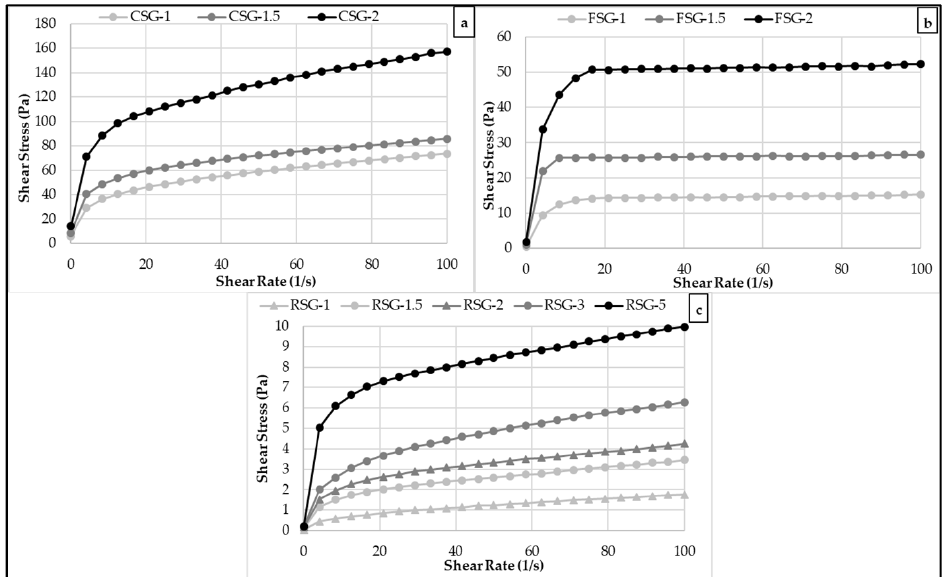
Figure 2. Steady shear rheological properties of the FSG (flaxseed byproduct gum), CSG (chia seed byproduct gum), and RSG (rocket seed byproduct gum) solutions with different concentrations (( a ) CSG (1–2%), ( b ) FSG (1–2%), ( c ) RSG (1–5%)).